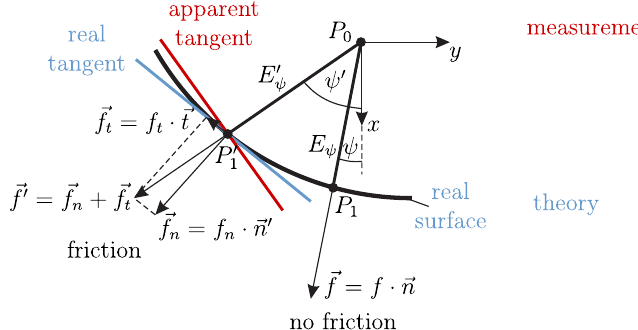
Figure 13. Schematic representation of two deformation states at the same clamping position P 0 where one is affected by friction and the other one is the reference state without friction. In the presence of friction, the quantities are marked with an apostrophe— (cid:126) f t is the tangential force component with the magnitude f t and direction (cid:126) t , (cid:126) f n is the normal force component with the magnitude f n and direction (cid:126) n (cid:48)